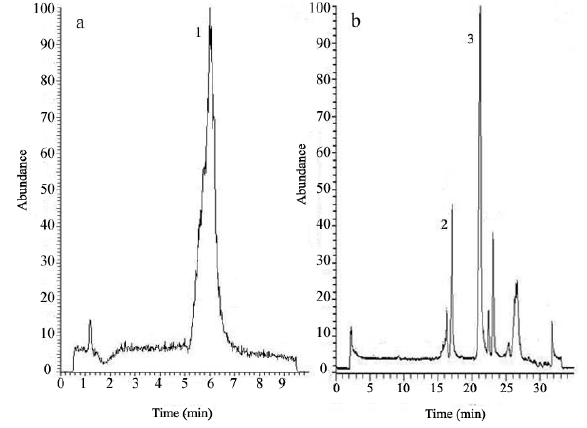
Figure 3. Total ion chromatogram (TIC) of the standard solutions of Transcutol ® and Labrasol ® detected by LC-MS. Peak 1 in chromatogram ( a ): Transcutol ® , Peaks 2 and 3 in chromatogram ( b ): caprylic acid and capric acid in Labrasol ® , respectively.